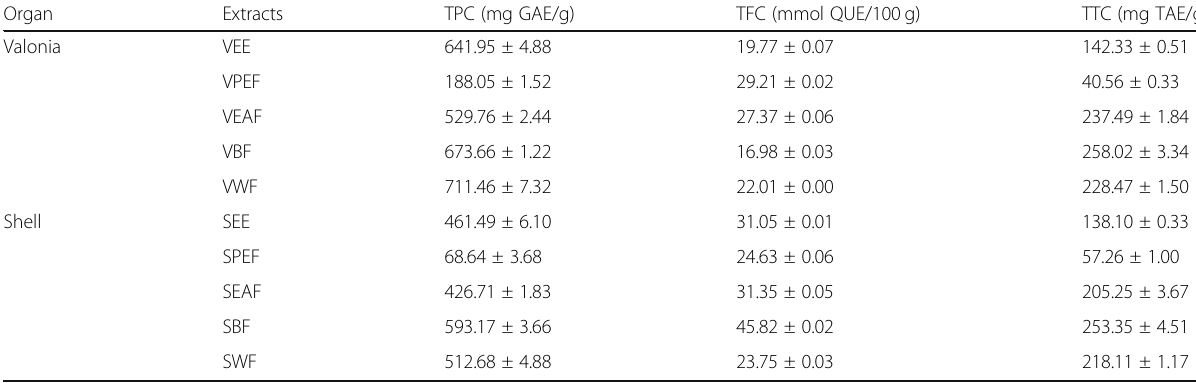
Each value represented in tables are means ± SD ( n